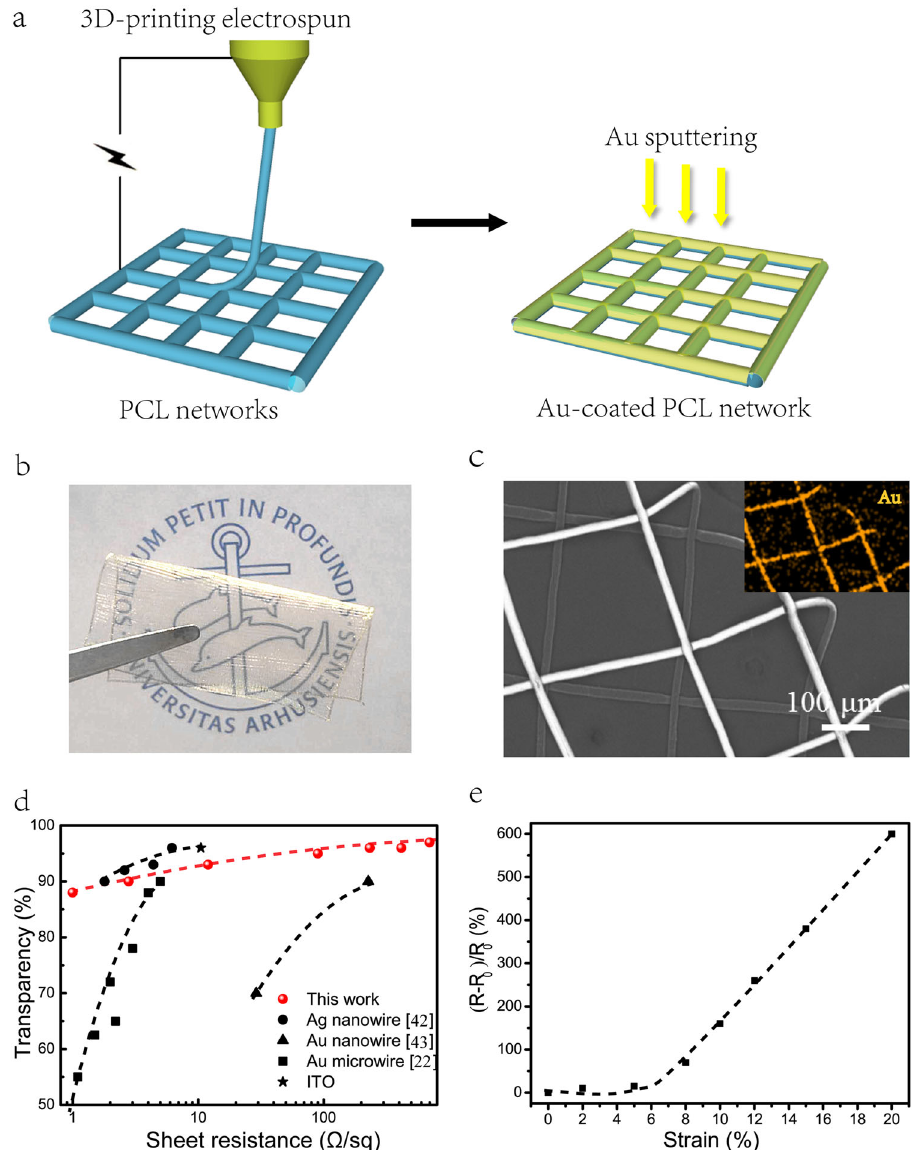
Fig. 1 a Schematic of Au network preparation method. b Photograph of an Au network electrode bended in half. Its transparency is illustrated by the visibility of the Aarhus university logo that is behind Au networks. c SEM images of the bended Au networks. Inset shows the corresponding EDS mapping image. d Sheet resistance versus optical transmission (at 550 nm) for silver and Au networks. e Variations in relative resistance of 80nm-Au network at stretching strains ranging from 0 to